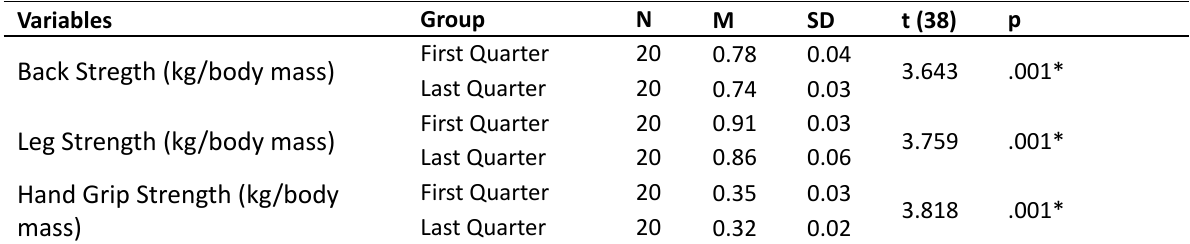
Table 3. The comparison of relative muscular strength performance between the relative age groups.